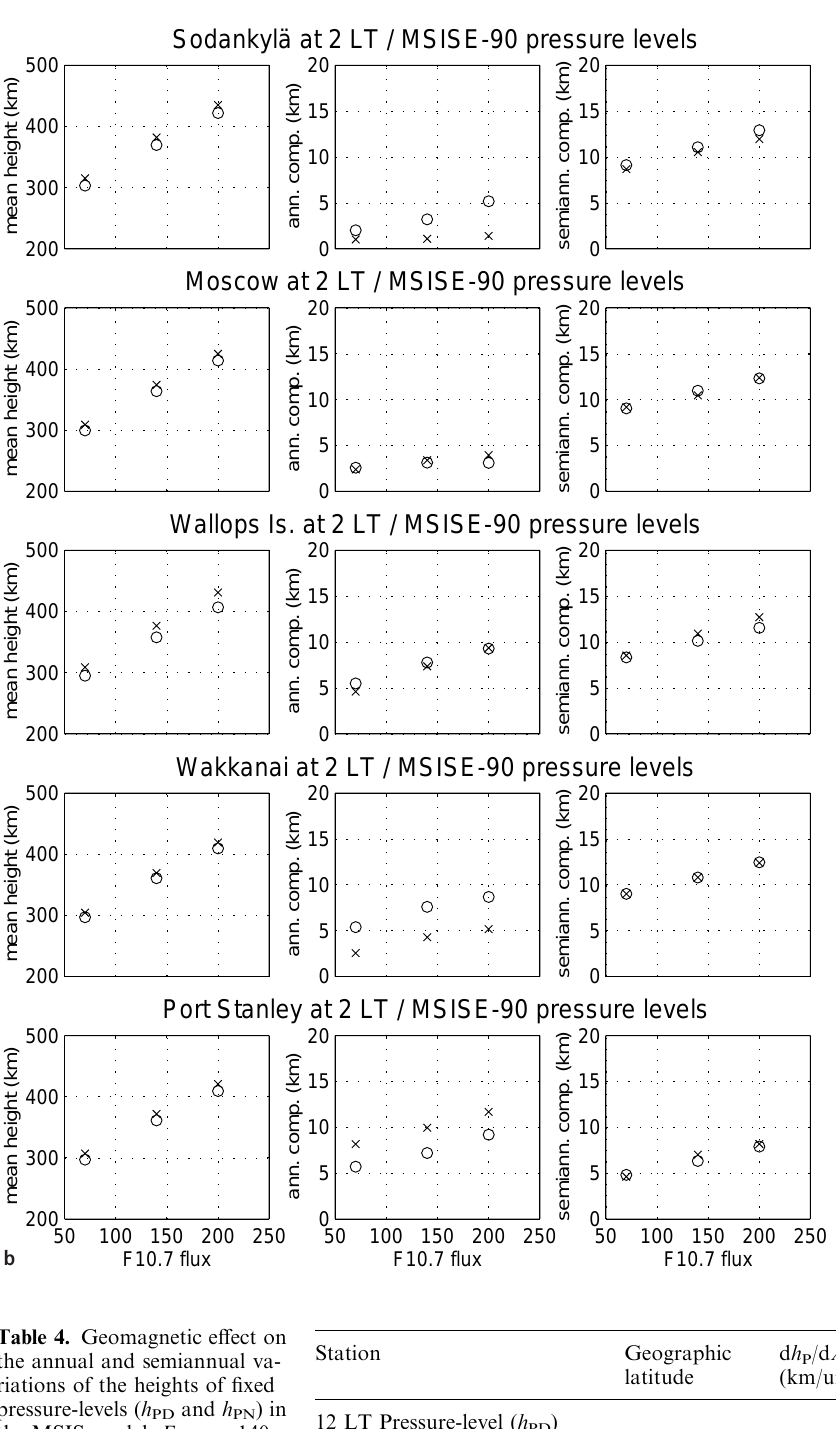
Table 4. Geomagnetic e(cid:128)ect on the annual and semiannual va- riations of the heights of fixed pressure-levels ( h and h ) in PD PN the MSIS model, F = 140, 10.7 assuming the annual amplitude of A p to be ( A p) = 1.5 and the 1 semiannual amplitude to be ( A p) = 2.5, as described in 2 Sect.